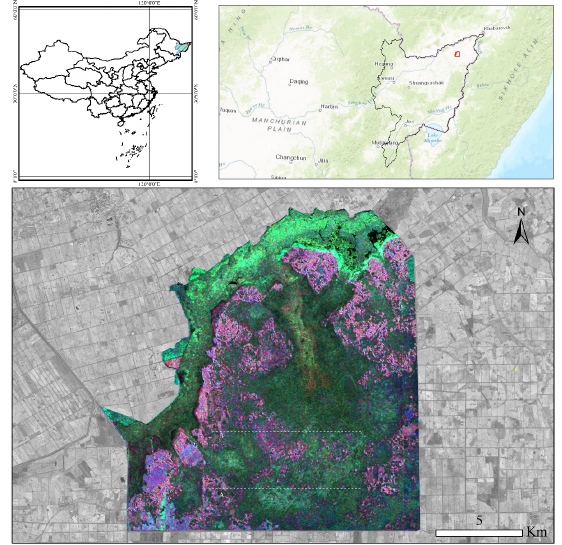
Figure 1 Location of the study area ， The false color image was derived from the RGB combination of C-band Radarsat-2 Cloude&Pottier H/A/alpha polarization decomposition